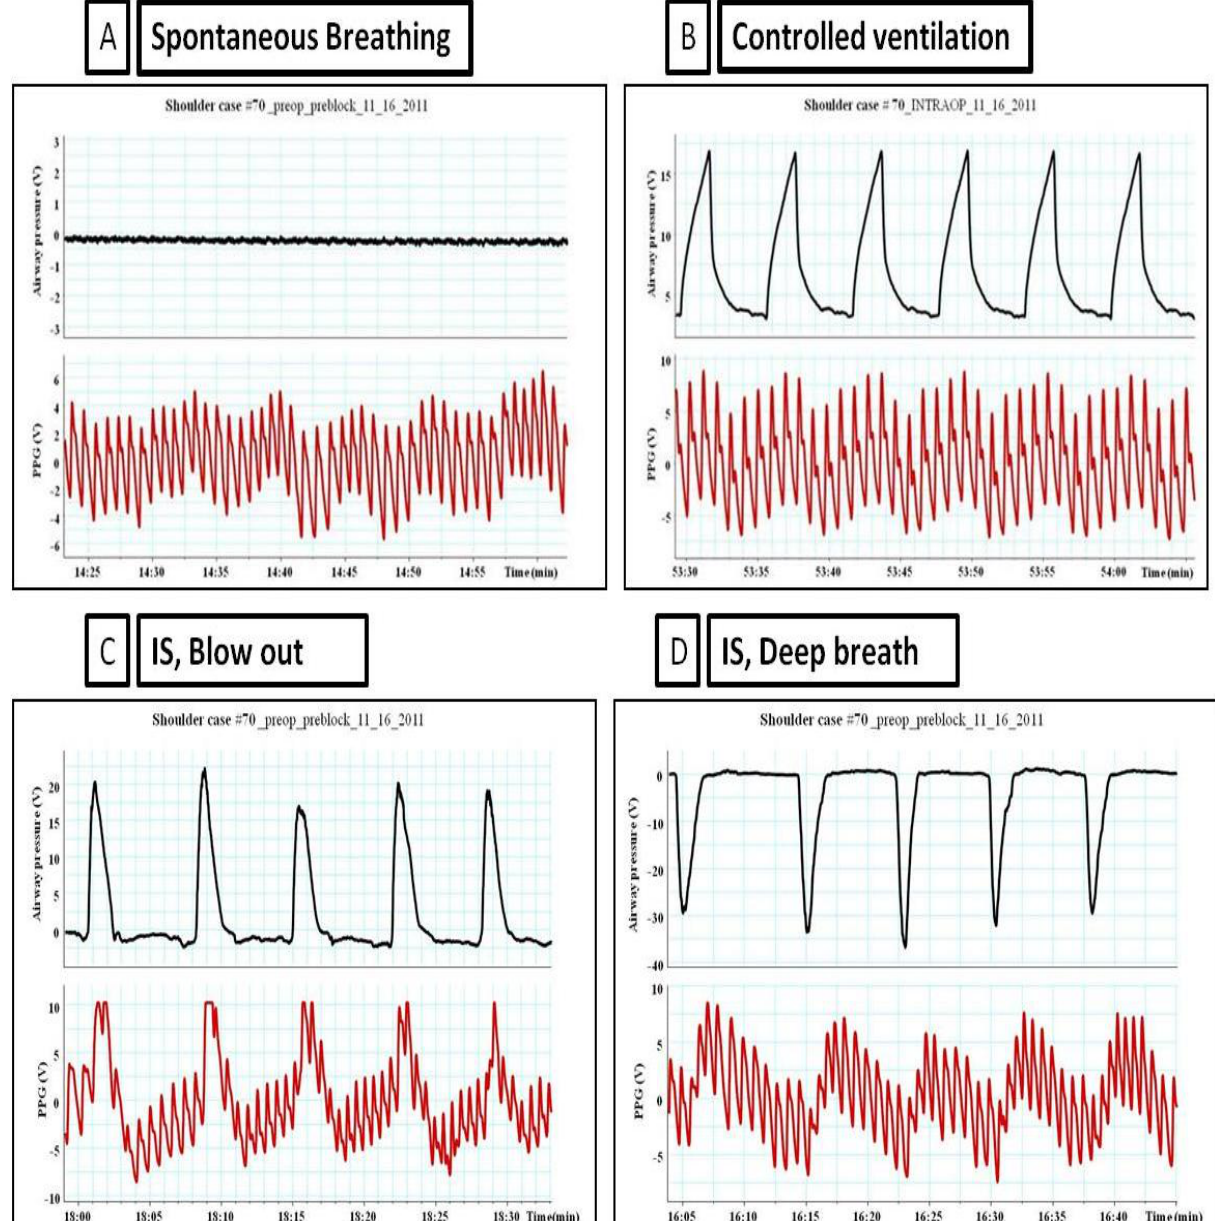
Figure 5. The impact of different types of ventilation on PPG waveforms. ( A ) Spontaneous breathing. ( B ) The impact of mechanical ventilation (volume controlled) on the PPG waveforms. ( C ) Patient is blowing out through the incentive spirometry; patient is generating positive 20 cm H O, notice the change in PPG waveforms which looks like 2 Valsalva maneuvers (looks like the same effect of expiratory resistor). ( D ) Patient taking deep breath through incentive spirometry, maximum negative airway pressure was a round 30 cm H O, notice that PPG waveforms are an exaggeration of the normal spontaneous 2